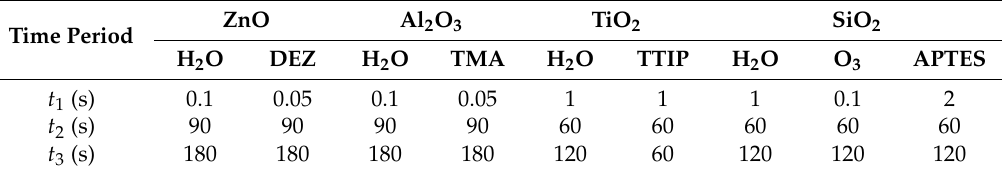
Table 3. Timing for ALD processes, with t 1 being the precursor pulse time, t 2 the exposition time, and t 3 the purge lapse. For each material, the exposure times used for each precursor are shown by columns. Note that the precursors and times for Al 2 O 3 are similar, either used for the conformation of AZO or for the Al 2 O 3 dielectric material